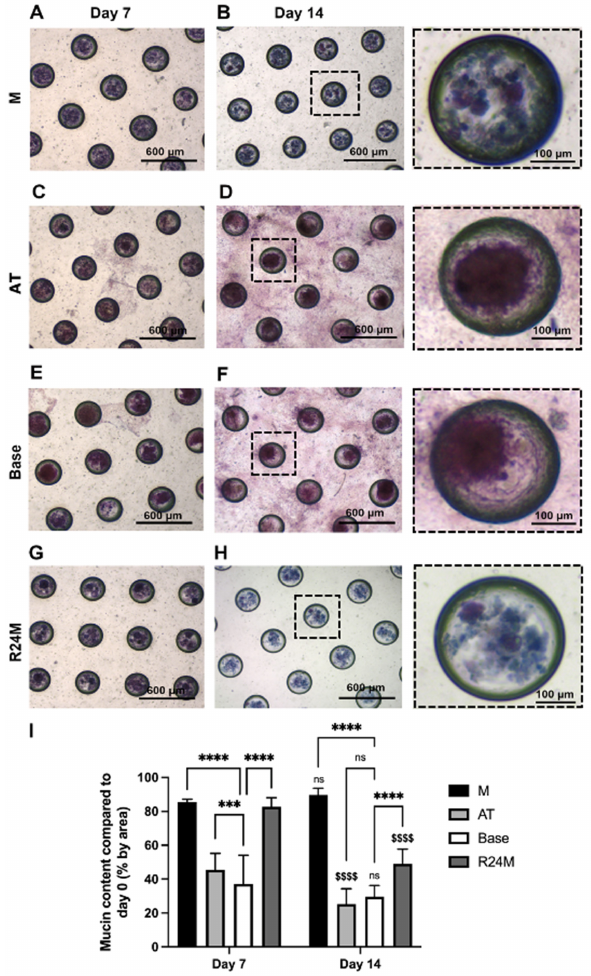
Figure 10. Mucin staining is preserved in M and R24M media. PAS-AB staining for M ( A , B ), AT ( C , D ), base ( E , F ), and R24M ( G , H ) media at day 7 and day 14, respectively. Quantification for the percent mucin content by area compared to day 0 tissue ( I ). Data are represented as mean ± SD, n = 3. Statistics were calculated using two-way ANOVA with Sidak’s post-hoc test. Brackets with asterisks compare between media conditions on the same day: ns = nonsignificant, *** p < 0.001, **** p < 0.0001. Money signs on day 14 data compare between time points for the same media condition: ns = nonsignificant, $$$$ p < 0.0001. Boxed MBs in ( B , D , F , H ) correspond with the magnified images to the right.